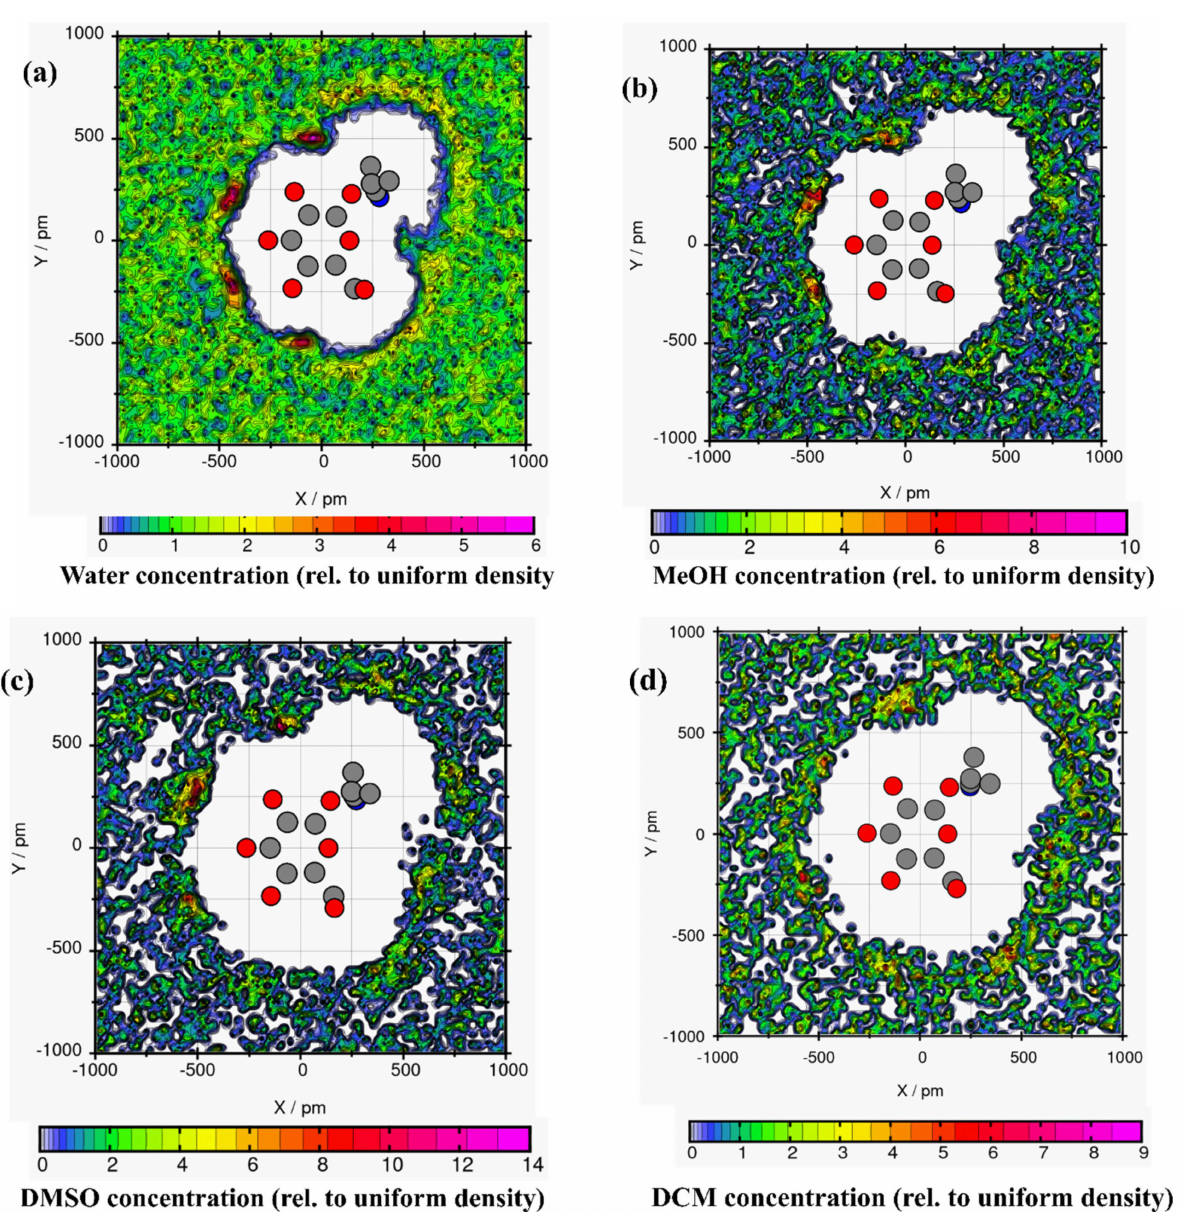
Figure 4. The average solvent molecules around linamarin ( a ) water, ( b ) MeOH, ( c ) DMSO and ( d ) DCM atoms displayed here are heavy atoms; C (grey), N (blue) and O (red) atoms of linamarin are drawn as a